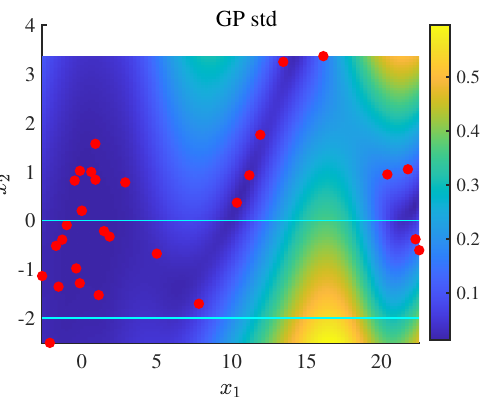
Figure 5. Gaussian process standard deviation, kernel = Square exponent.